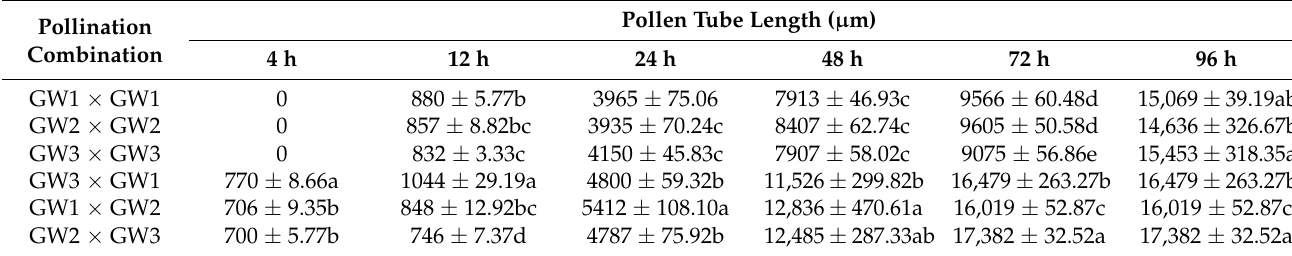
Table 3. The growth of the selfed and crossed pollen tubes.